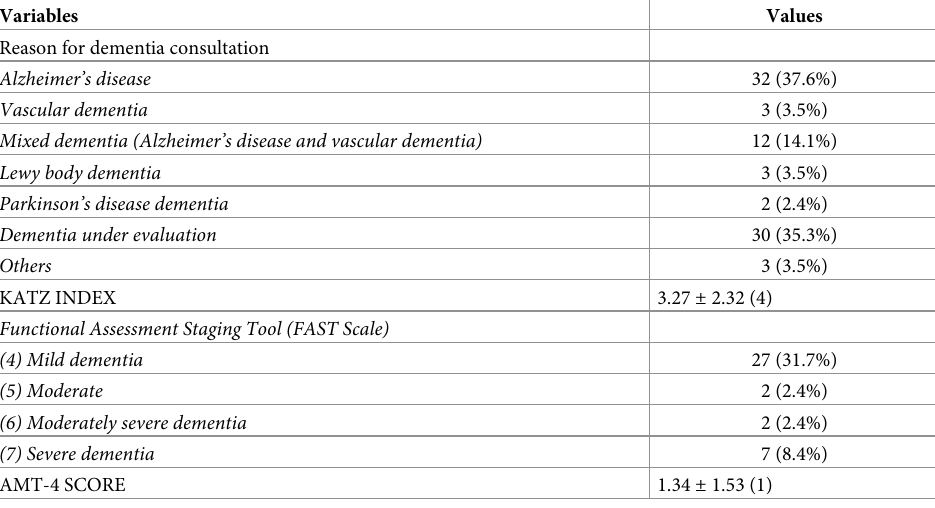
Table 2. Dementia-related medical characteristics and functional assessment staging tool of study